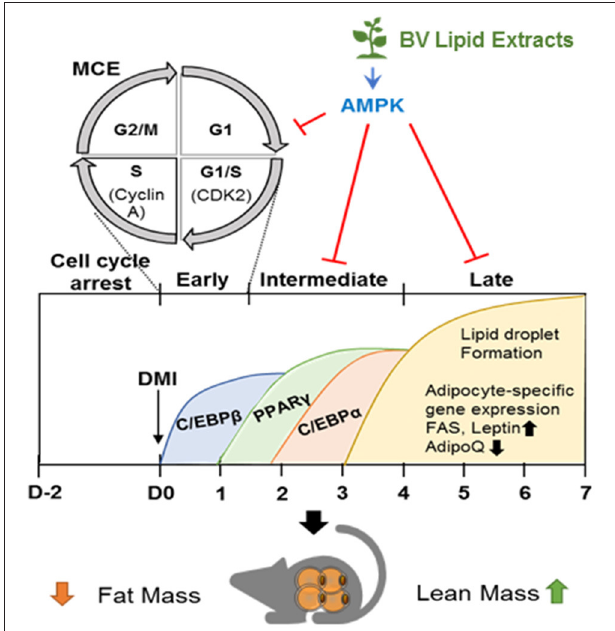
FIGURE 5 | BV lipid extracts inhibit adipogenesis through regulating AMPK. The diagram illustrates a proposed mechanism by which BV lipid extracts limit adipogenesis including MCE suppression, decreased expression of transcriptional factors, and of adipocyte markers through, at least in part, stimulating AMPK. This inhibitory effect of BV lipid extracts are associated with the loss of fat mass and an increase of lean